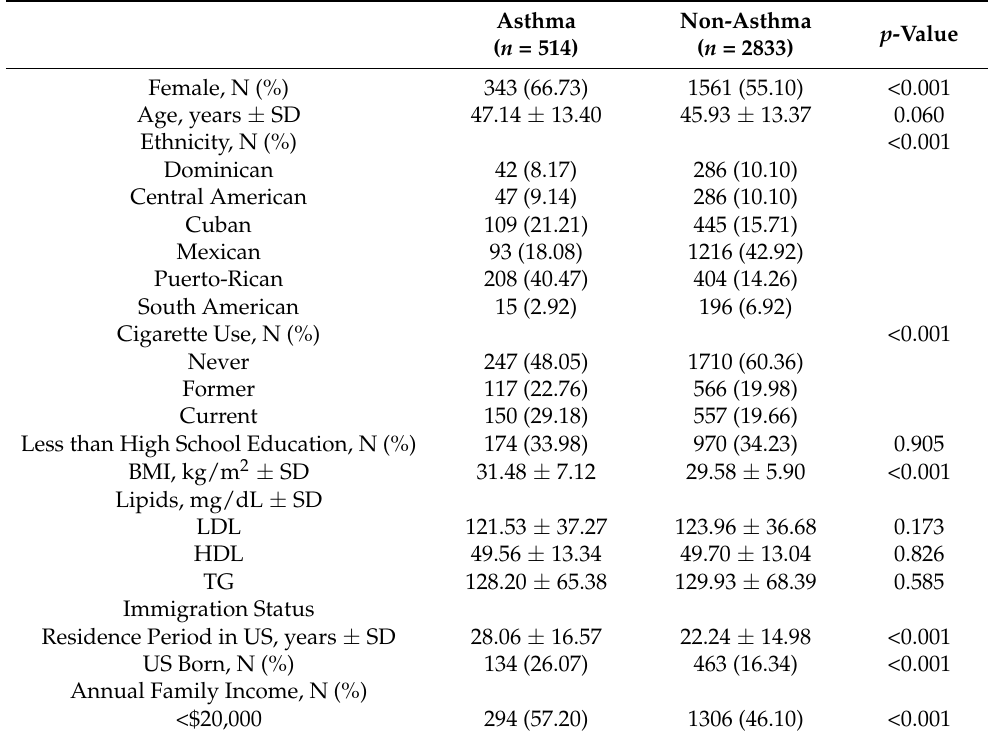
Table 1. Demographic Characteristics of the Samples in Study ( n = 3347).